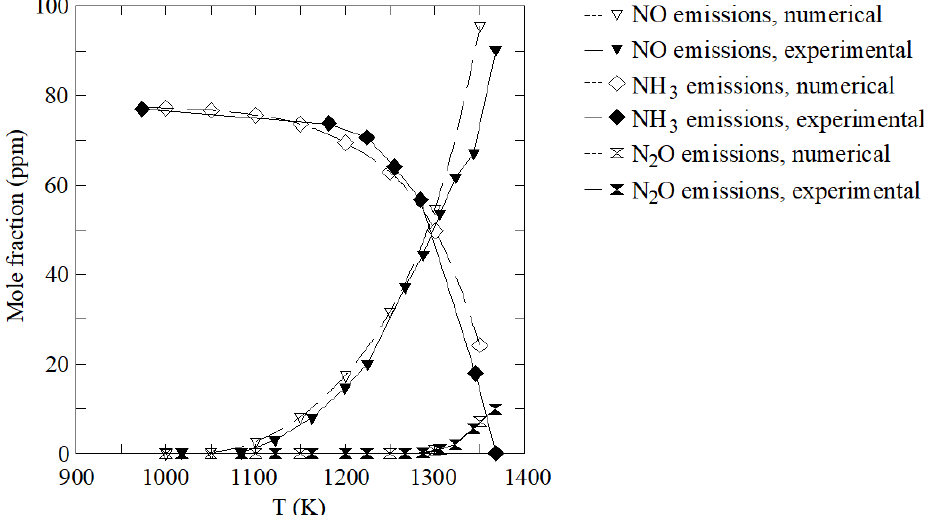
Figure 7. Comparison between the numerical results obtained with the CFD code and the experiments of Hulgaard and Kim Dam-Johansen [44]. Adapted with permission from Ref. [44], copyright owner: John Willey and Sons .